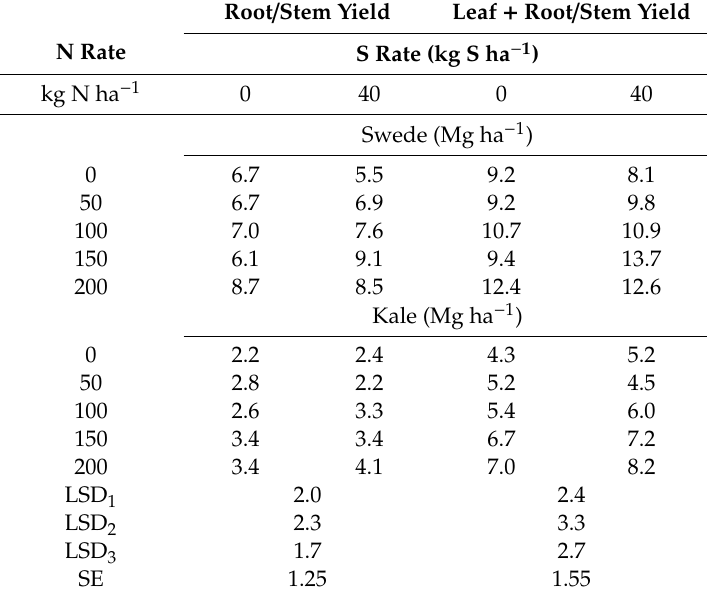
Table 5. Swede and kale root / stem yield and leaf + root / stem yield with five nitrogen (N) rates and two sulfur (S) rates averaged across three environments at Prosper and Walcott, ND, USA, in 2012 and 2014. Root / Stem Yield Leaf + Root / Stem Yield N Rate S Rate (kg S ha − 1 ) kg N ha − 1 0 40 Swede (Mg ha − 1